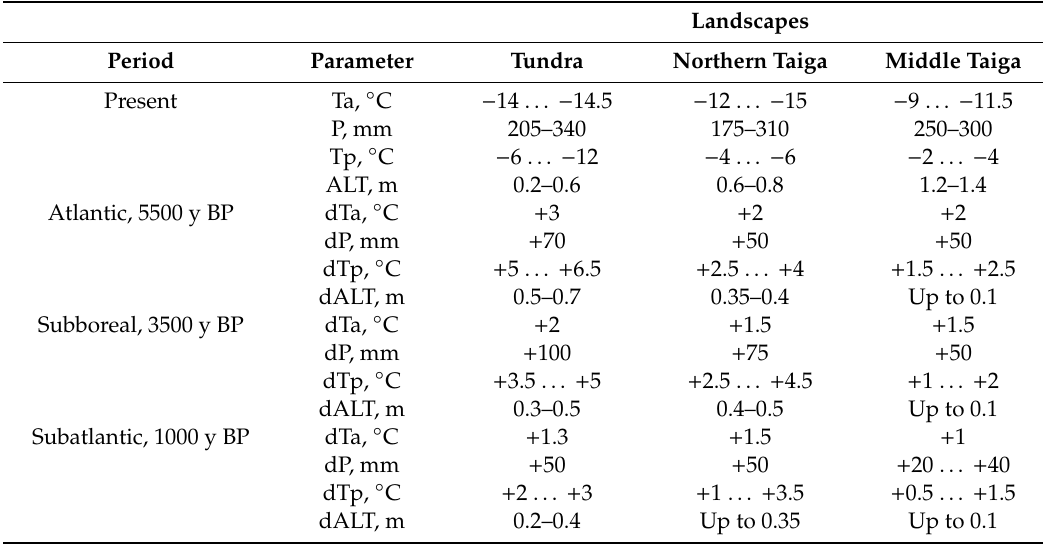
Table 1. Comparative estimation of the main climatic and permafrost characteristics in the Holocene warm intervals and the